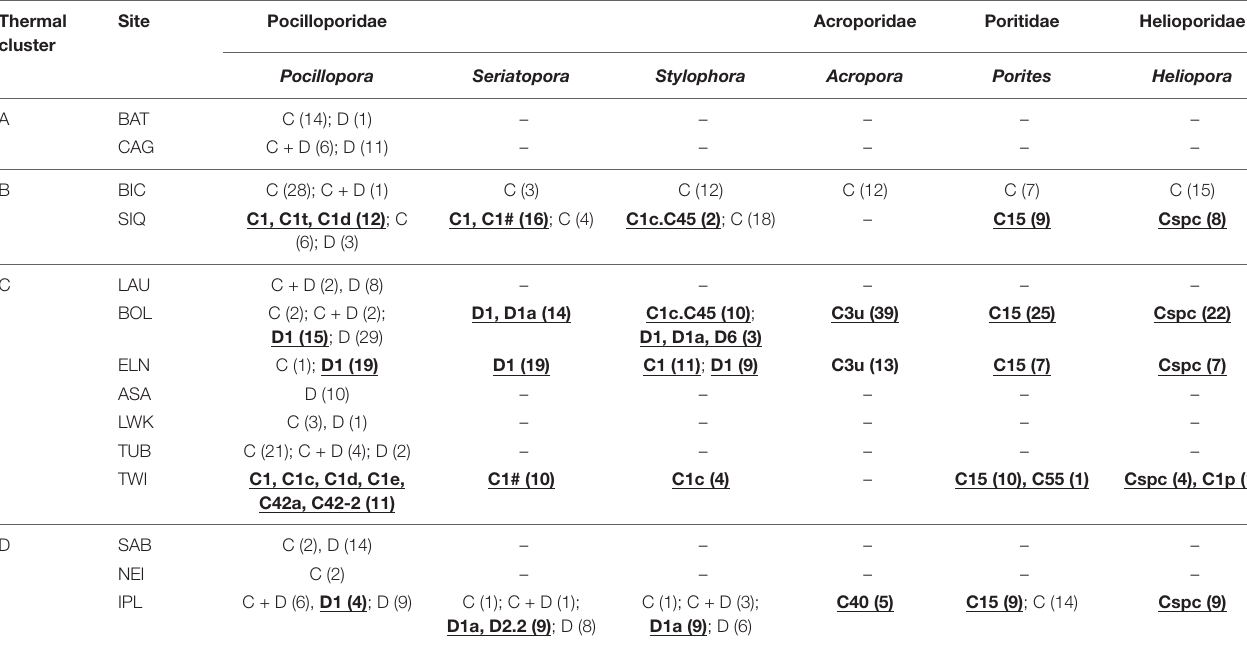
TABLE 2 | Dominant zooxanthellae detected from four coral families across 14 sampling sites clustered according to thermal regime. Thermal